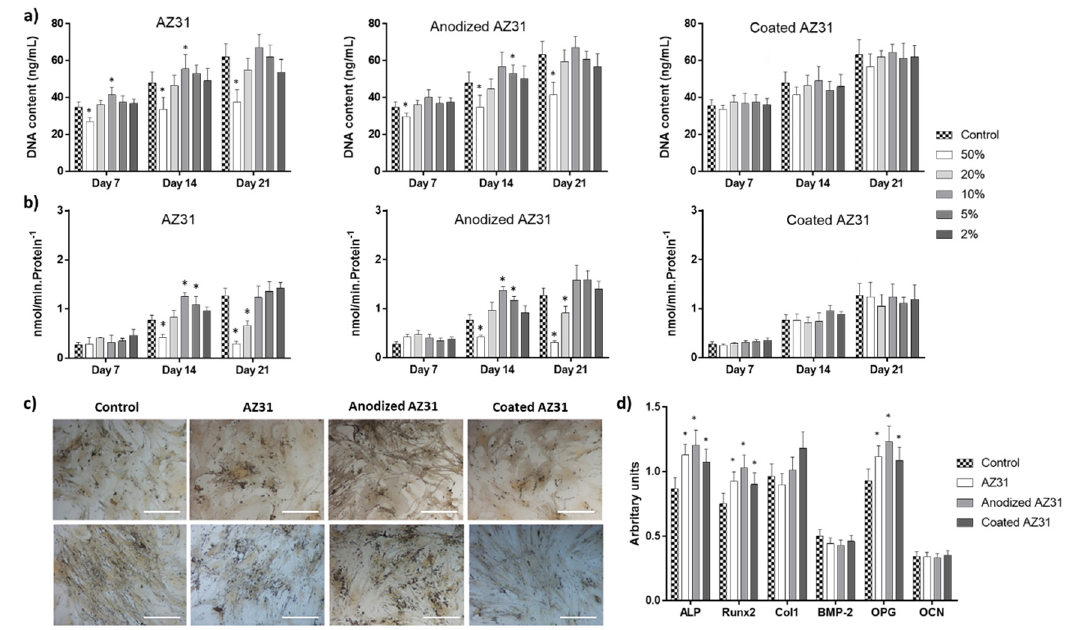
Figure 5. Human MSCs cultures exposed to the extracts from the Mg-based substrates (AZ31, anodized AZ31 and coated AZ31), at days 7, 14 and 21. ( a ) DNA content; ( b ) ALP activity; ( c ) ALP staining; ( d ) expression of osteoblastic genes. * Significantly different from control cultures (absence of the extracts).